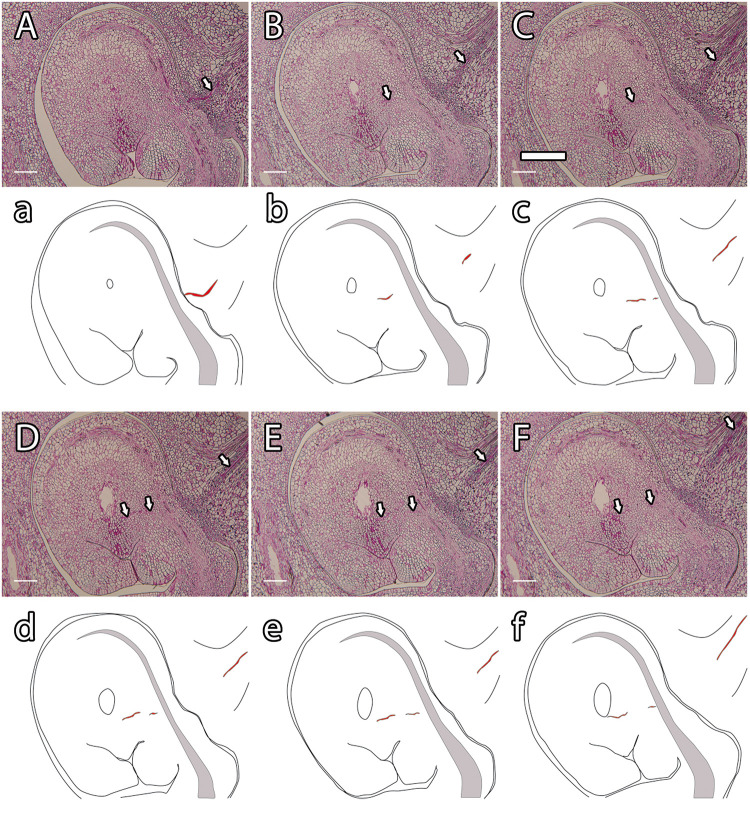
Histological observation of pollen tube growth in mango (A–F) and its schematic representation (a–f). A pollen tube (arrowhead and red line) growing along the stylar transmitting tissue (A; a), the ponticulus, the distal part of the funiculus (B,C; b,c), the nucellus (D–F; d–f) and reaching the embryo sac (F; f). (A–F) PAS staining. Scale bars, 100 μm.